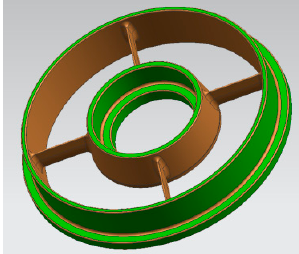
Figure 1. Simulation model of case. The out outer diameter of the outer ring is about 430 mm, and the inner diameter of the inner ring is about 200 mm. The average wall thickness is about 8–10 mm. The height of the case is about 70 mm.